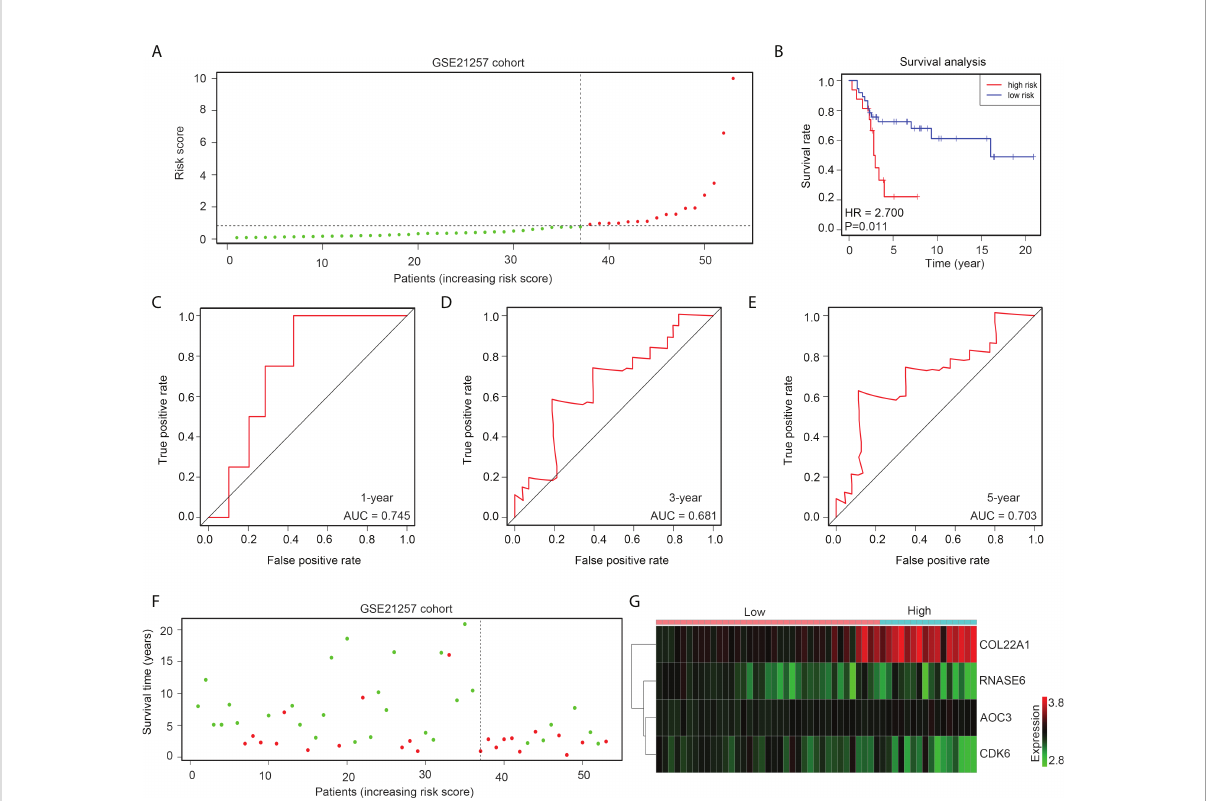
FIGURE 5 The risk model exhibits high prognostic value in the GSE21257 veri fi cation cohort. (A) OS tissues in GSE21257 were divided into low- and high- risk groups according to median risk scores. (B) Kaplan survival analysis indicated the difference between low- and high-risk group OS tissues in GSE21257. (C – E) ROC analysis of the risk model for the 1-year, 3-year, and 5-year survival rates for OS patients in GSE21257. (F) Alive and death cases between low- and high-risk group OS tissues in GSE21257. (G) Expression of COL22A1, CDK6, RNASE6 and AOC3 between low- and high-risk group OS tissues in